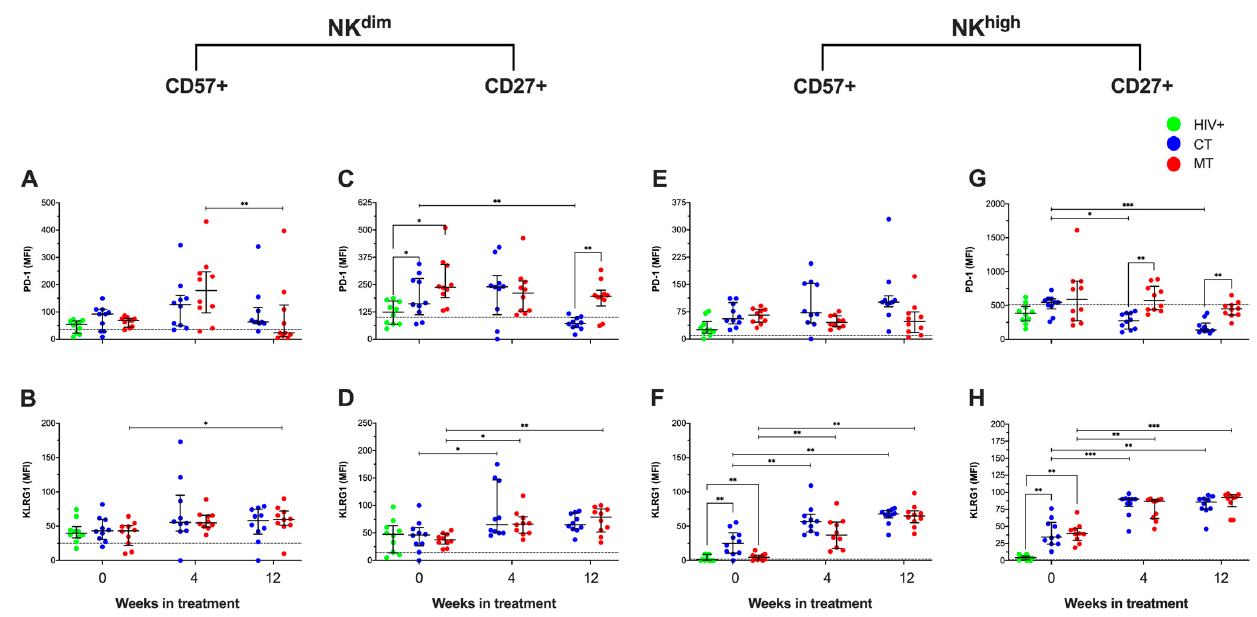
Figure 7. Expressions of the immune checkpoint receptors PD-1 and KLRG1 are differentially modified depending on the treatment scheme in KS/HIV patients. PD-1 and KLRG1 expression (MFI) on CD57+ and CD27+ cells of NK dim ( A , B , E , F ) and NK high ( C , D , G , H ) cell subsets of HIV+ and KS/HIV patients were evaluated across the follow-up weeks in each group. The black dashed line represents the median value of HIV-negative men. Green dots represent HIV+ asymptomatic men, blue dots represent CT and red MT participants. Data are represented as median values and IQR. Statistical